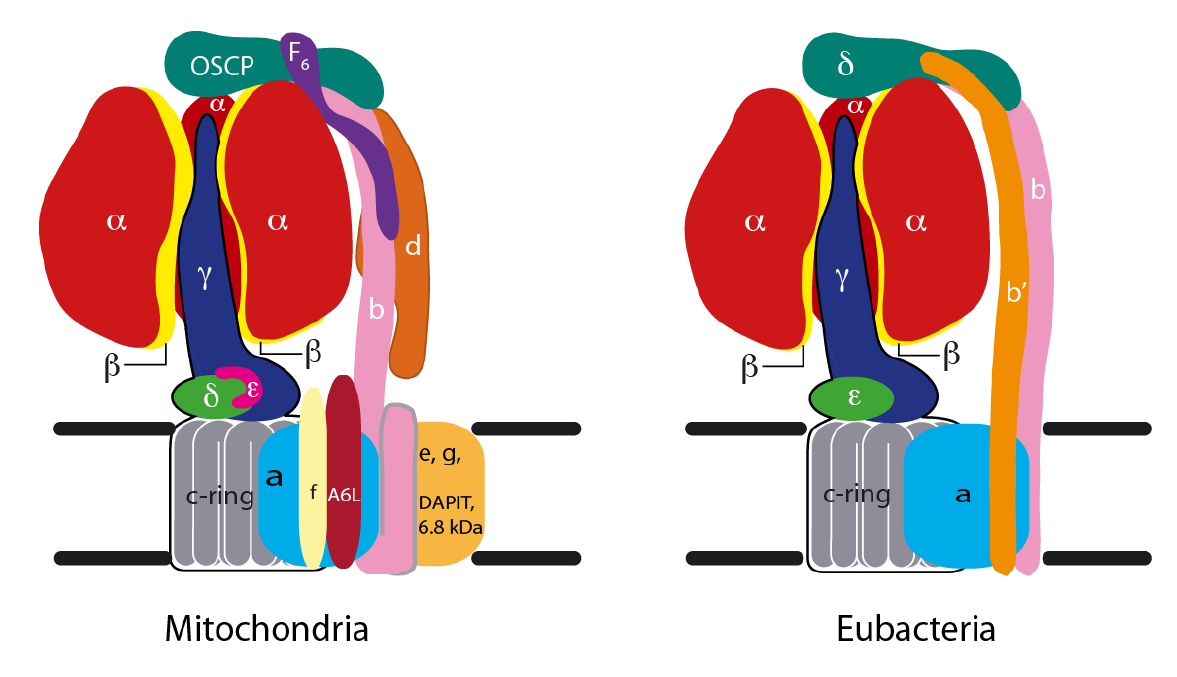
Figure 3: Schematic subunit composition of ATP synthase. The bacterial and chloroplast ATP synthases have comparable subunit composition, with α β γδε constituting F and F comprising of ab c . Subunits γ and ε shape a primary stalk that non-covalently interacts 3 3 1 0 2 10–15 with the membrane bound, hydrophobic c-ring. The proteolipidic oligomer c rotates in opposition to the peripheral stator that is made from ab and δ. The stator restricts rotation of the α β hexamer, which provides six nucleotide binding sites (each located at αβ-subunit 2 3 3 interface) for reversible ATP synthesis. Ions are translocated across channels at the a–c ring interface, generating a torque on the central stalk γε. The γ-subunit which forms α-helical coiled-coil structure is embedded in the F -hexamer. The torque of γ causes alternating 1 conformational adjustments in the β-subunits, leading to differences in nucleotide binding affinities (open, tight and free), which eventually bring about ATP synthesis or hydrolysis. Mitochondrial ATP synthase possess the bacterial core set of subunits, but contain additional subunits in the F domain (subunits DAPIT and 6.8 kDa Proteolipid) and in the stator (subunits d and F6). OSCP (Oligomycin sensitivity- 0 conferring protein) is equivalent to δ subunit of bacterial